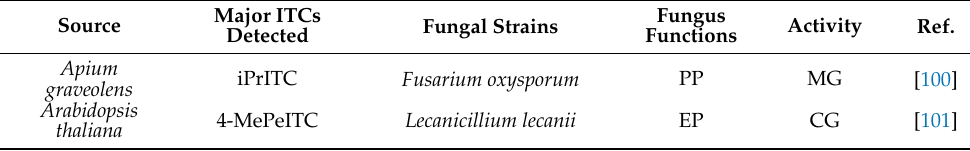
Table 2. A review of direct effects of isothiocyanate containing plant extracts in in vitro models using in-medium or vapor exposure. The concentration of isothiocyanates or glucosinolates were indicated in the manuscripts. Reoccurring genus names in the same cells are